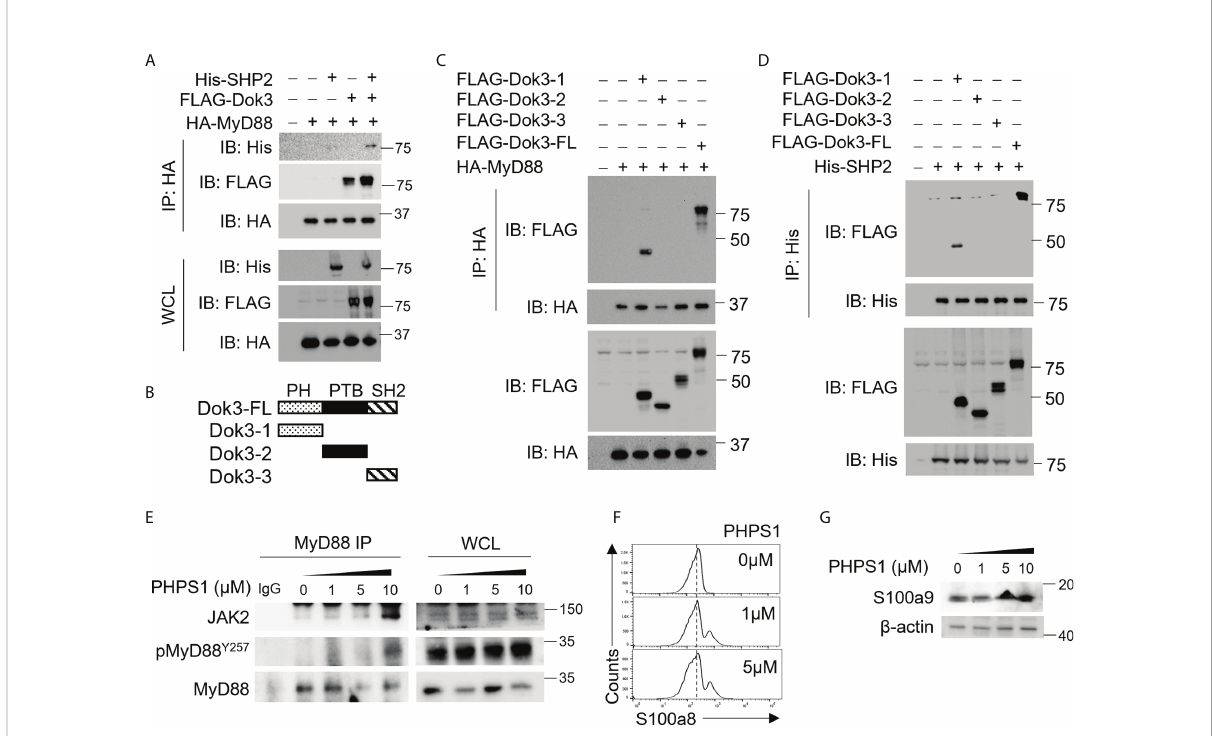
FIGURE 3 Dok3 recruits SHP-2 to de-phosphorylate MyD88 at Y257 in response to SARS-CoV-2 S protein engagement. (A) HEK293T cells were transfected with HA-tagged MyD88, FLAG-tagged Dok3 and His-tagged SHP-2. Cell lysates were IP with anti-HA antibody. Precipitates and WCL were immunoblotted with anti-HA, anti-FLAG and anti-His antibodies. Data shown are representative of 3 independent experiments. (B) Diagram depicting Dok3 full-length protein and truncation variants bearing individual PH, PTB, and SH2 domains. (C) HEK293T cells